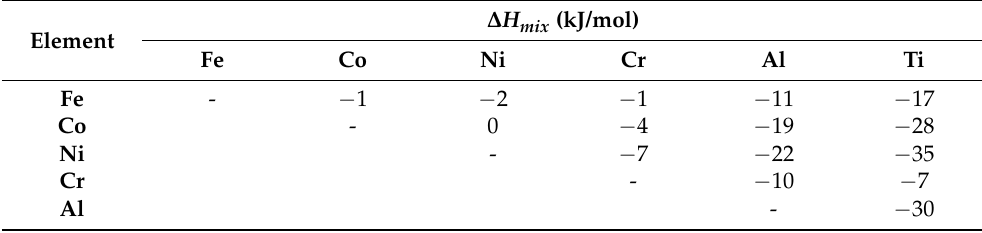
Figure 2. XRD patterns of Al x Ti 1− x HEAs’ coatings. Table 1. The mixing enthalpy among these element pairs. Adapted with permission from [29]. 2000, The Japan Institute of Metals.